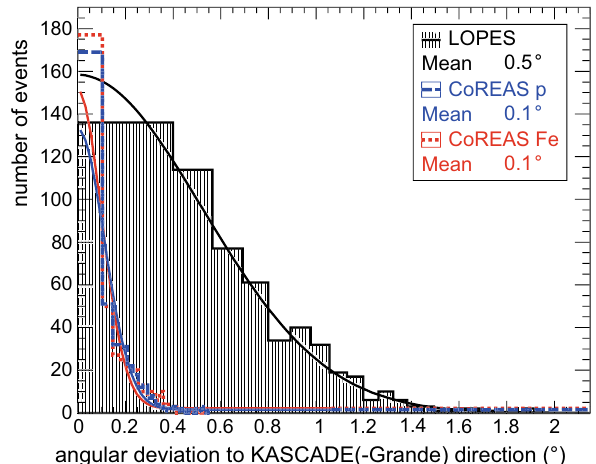
Fig. 15 Angular deviation between the arrival direction reconstructed by KASCADE or KASCADE-Grande, respectively, for the LOPES measurements and the CoREAS end-to-end simulations including noise.Simulationswithoutnoise(notshown, seeRef.[31])haveamean deviation of 0 . 05 ◦ . The variable bin size accounts for a constant solid angle covered by each